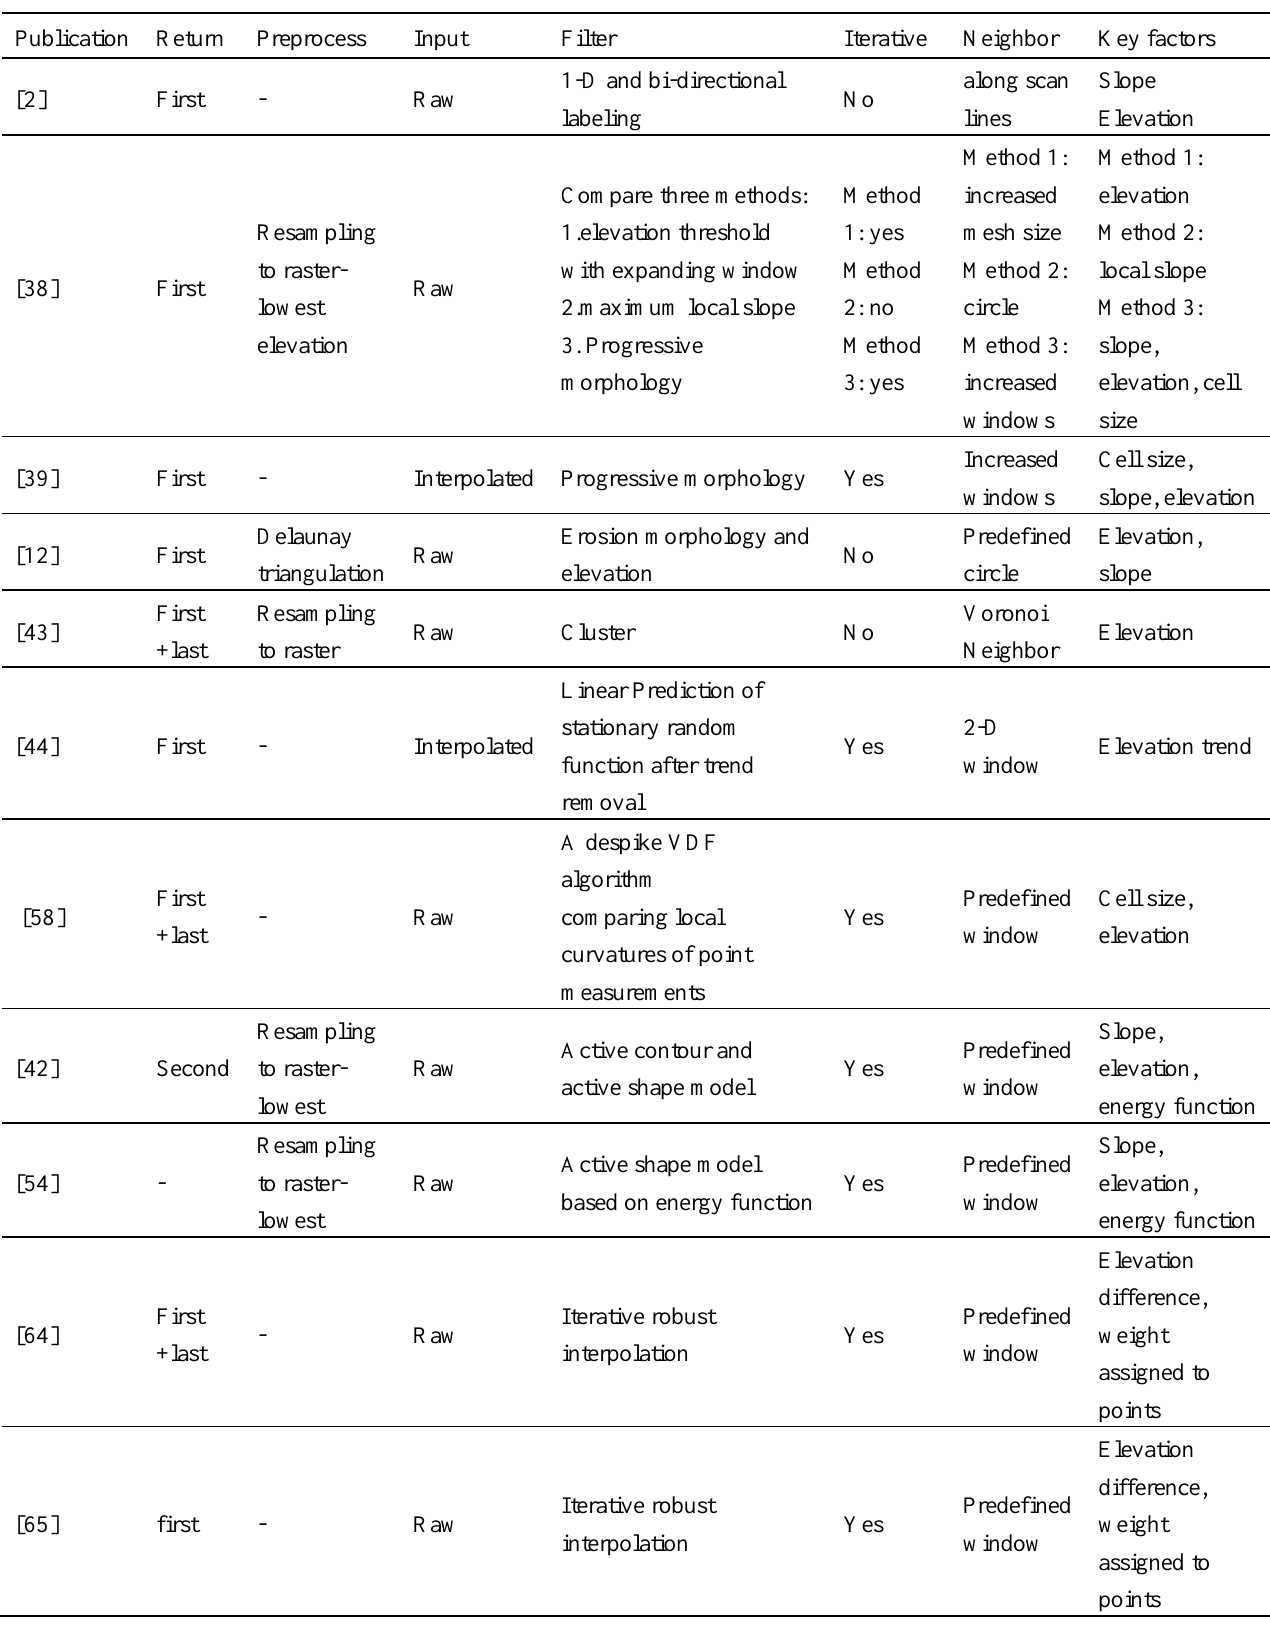
Table 3. Comparative table of key filter